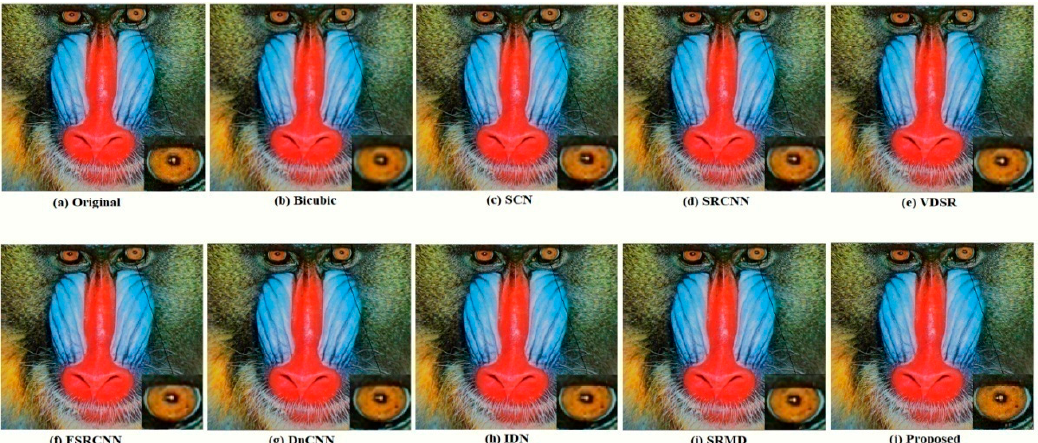
Figure 6. Visual comparison for a baboon image at the scale-up factor of 2.